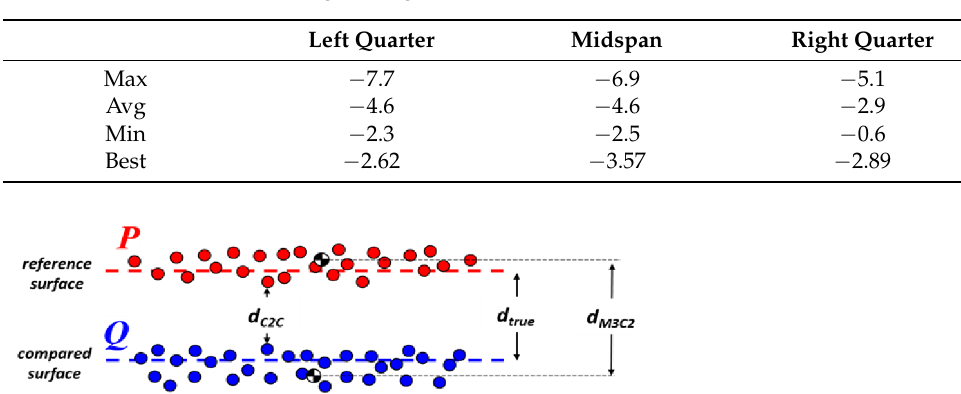
Table 11. Direct P2P results using ICP registration.